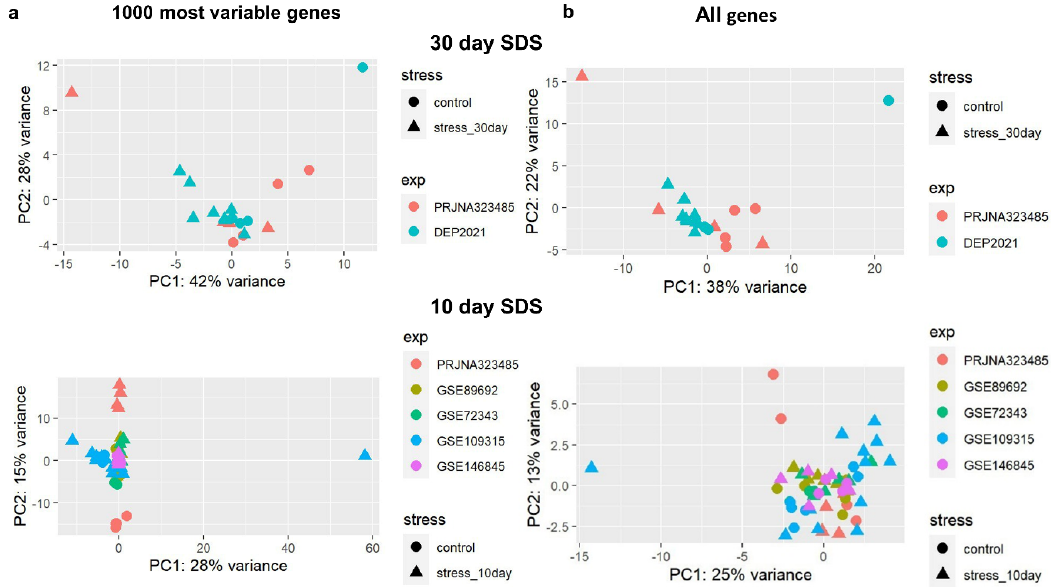
Figure 2. Principal component analysis (PCA) of all datasets included in meta ‐ analysis. ( a ) Based on 1000 most variable genes. ( b ) Based on all expressed genes (FPKM > 0.1) The scatter plots were based on PCA scores of the first two principal components (PCs).